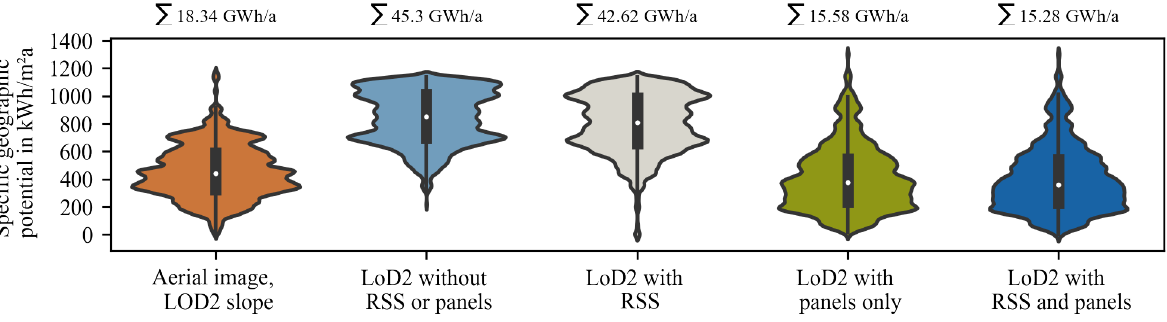
Figure 6. Specific geographical potential of roof segments in the study